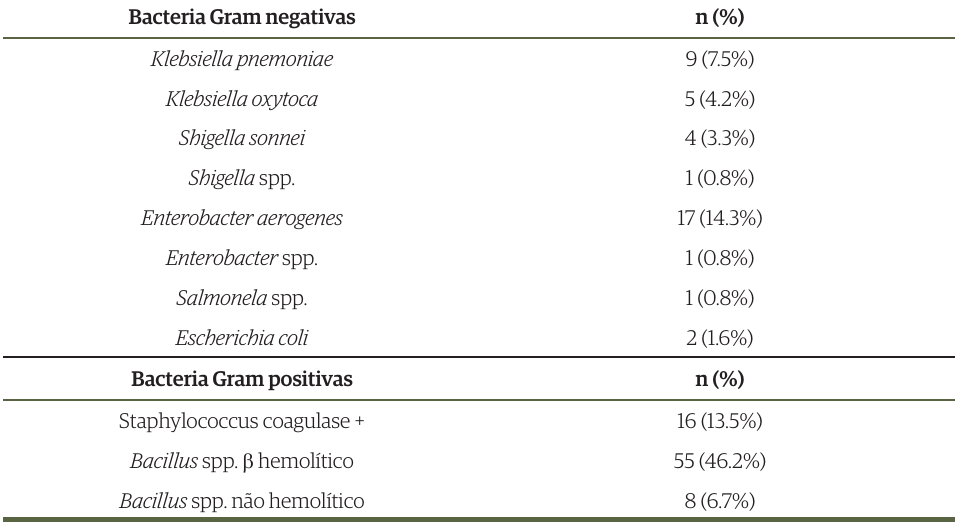
Table 3. Identification and percentage of bacteria isolated in samples of skin swabs from bitches submitted to elective ovariohysterectomy (OVH).